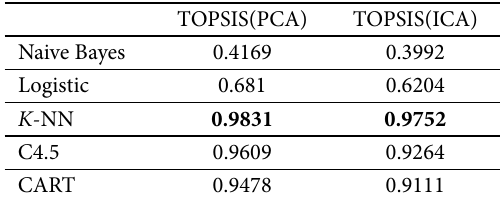
Table 5. Ranking of classifiers by